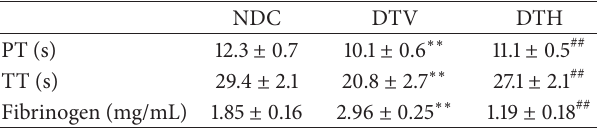
Table 2: Effects of HO-1 on coagulation